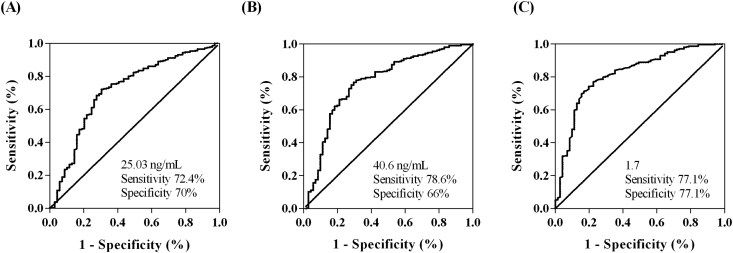
Serum TGF-β1 (A) and EDN (B) levels and their ratio (C) for predicting the WRS+ group among exposed workers. The receiver operating characteristic curve (ROC) analysis was performed to determine the cutoff value for predicting WRS. EDN, eosinophil-derived neurotoxin; TGF-β1, transforming-growth factor β1; WRS, work-related symptoms